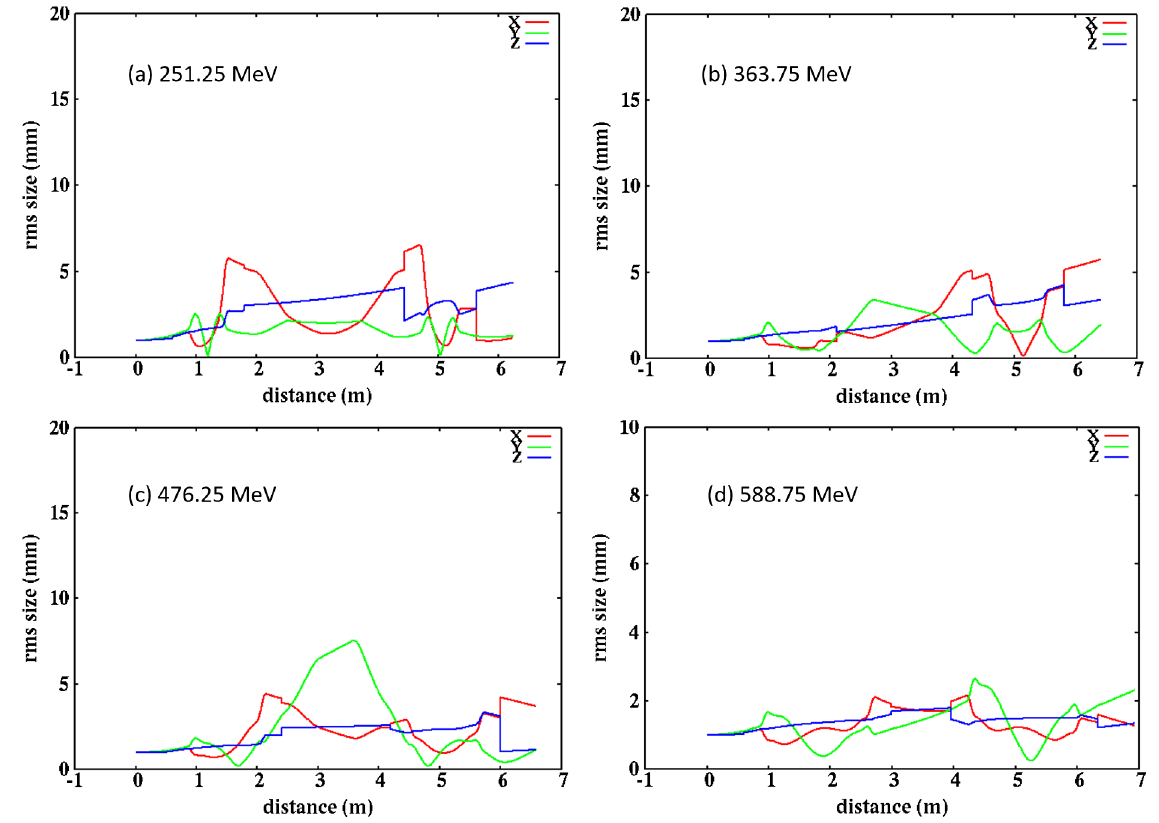
FIG. 15. Proton beam transverse and longitudinal RMS size evolution through the phase shifter (Table III) with 251.25 MeV (top left), 363.75 MeV (top right), 476.25 MeV (bottom left), 588.75 MeV (bottom right) kinetic energy, initial Waterbag distribution, and 40 mA